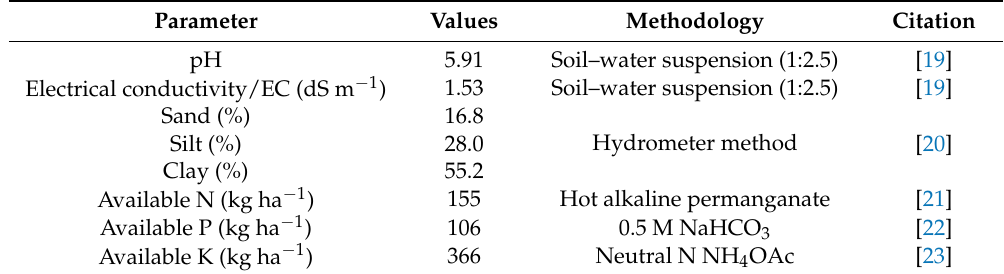
Table 1. Initial physico-chemical properties of the experimental soil (0–30 cm